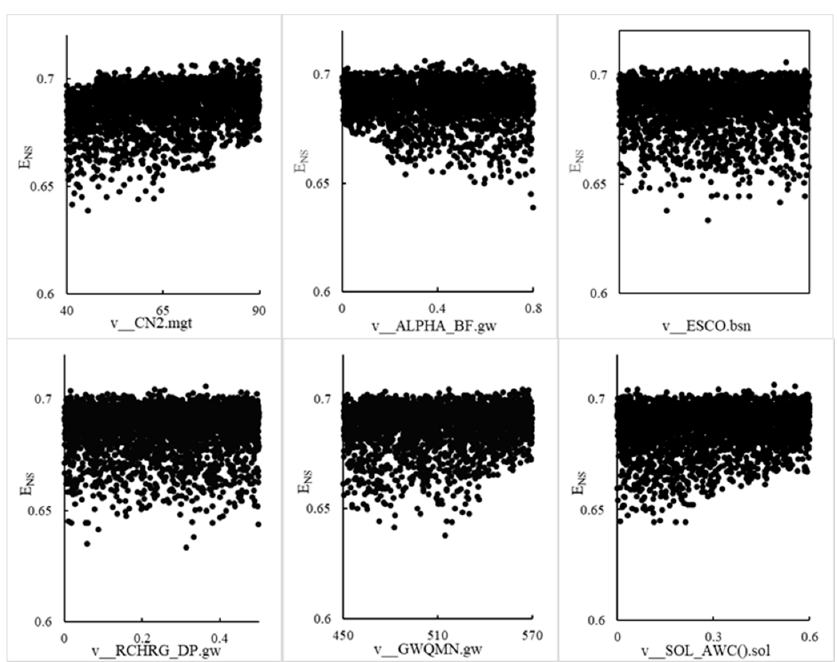
Figure 3. Parameter combination and Nash–Sutcliffe efficiency coefficient distribution diagram of the Xiaoqing River basin based on the GLUE method.